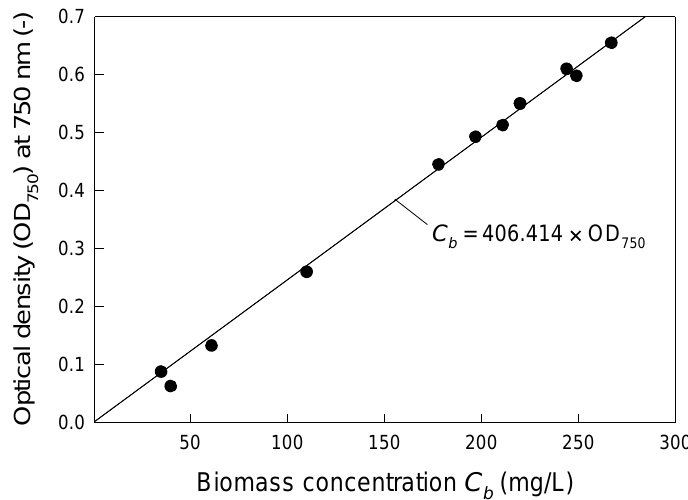
Figure 1. Standard plot of optical density versus biomass concentration.